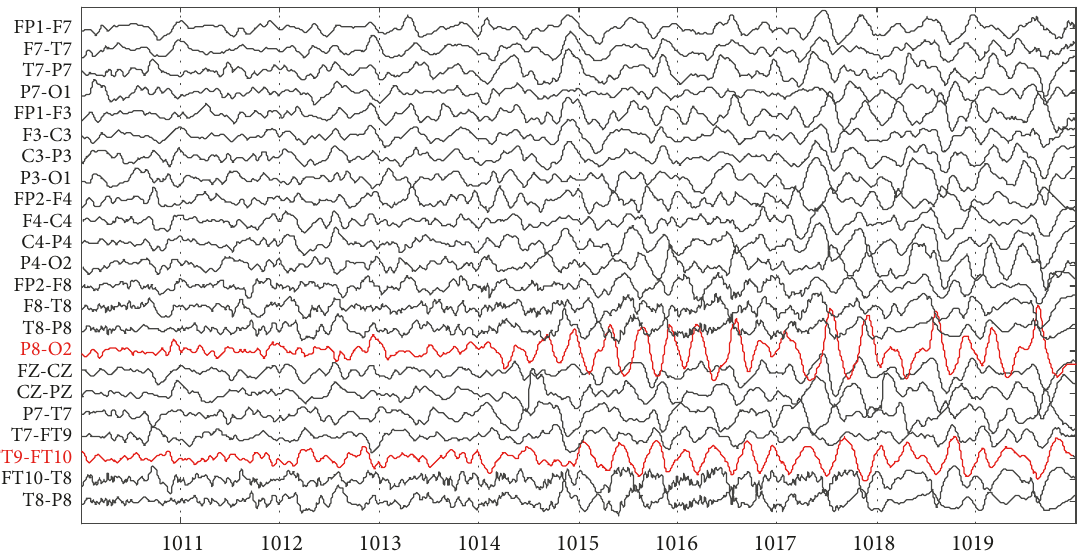
Figure 3: The continuous scalp EEG recordings with a seizure in Patient II. The EEG channels (P8-O2, FT9-FT10) involved in a seizure were marked as red.